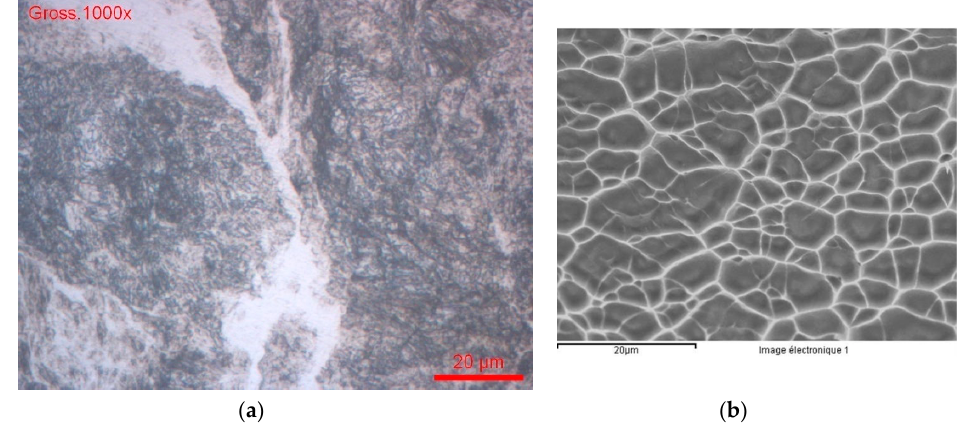
Figure 12. Ti13Nb13Zr nanostructured alloy ( a ) OM and ( b ) SEM images.